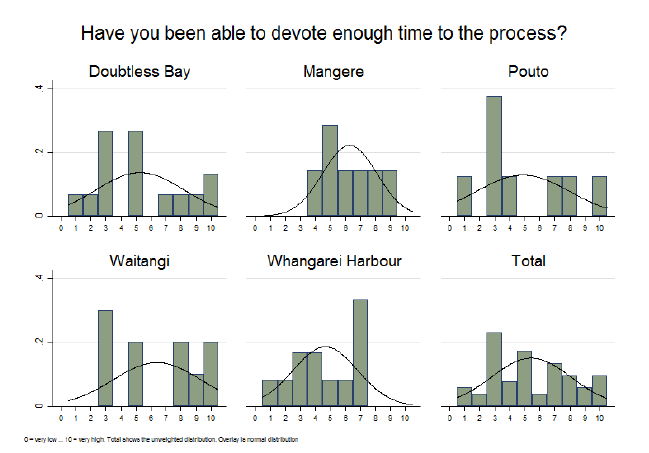
Figure A1.5 Results from the Northland processes at the same point in time, “Enough time to devote to the process”